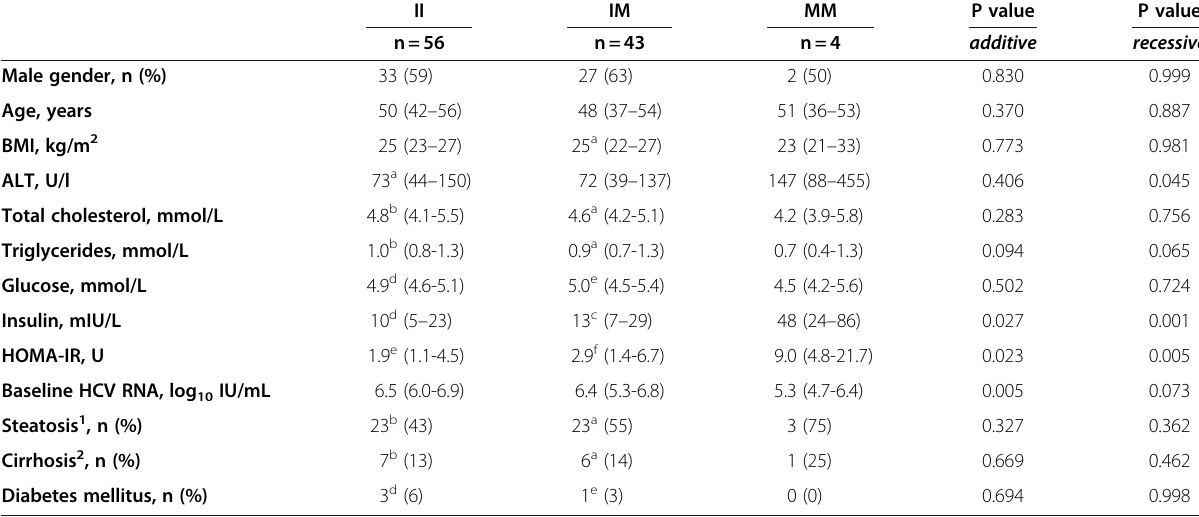
Table 2 Baseline characteristics according to PNPLA3 I148M sequence variant in HCV genotype 2 patients